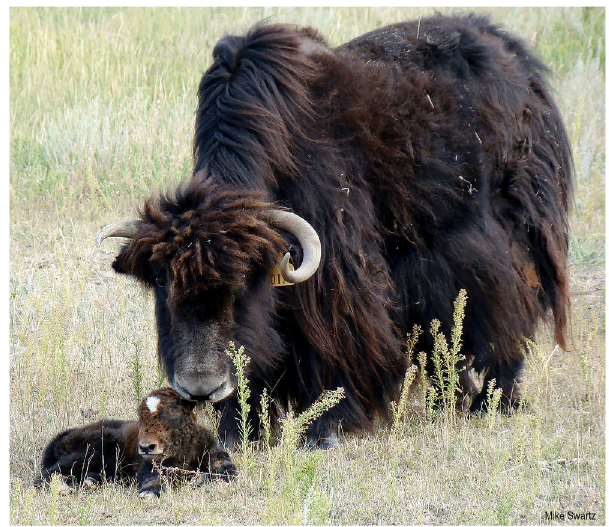
Figure 2. NA Reference yak Queen Allante and 2009 calf.